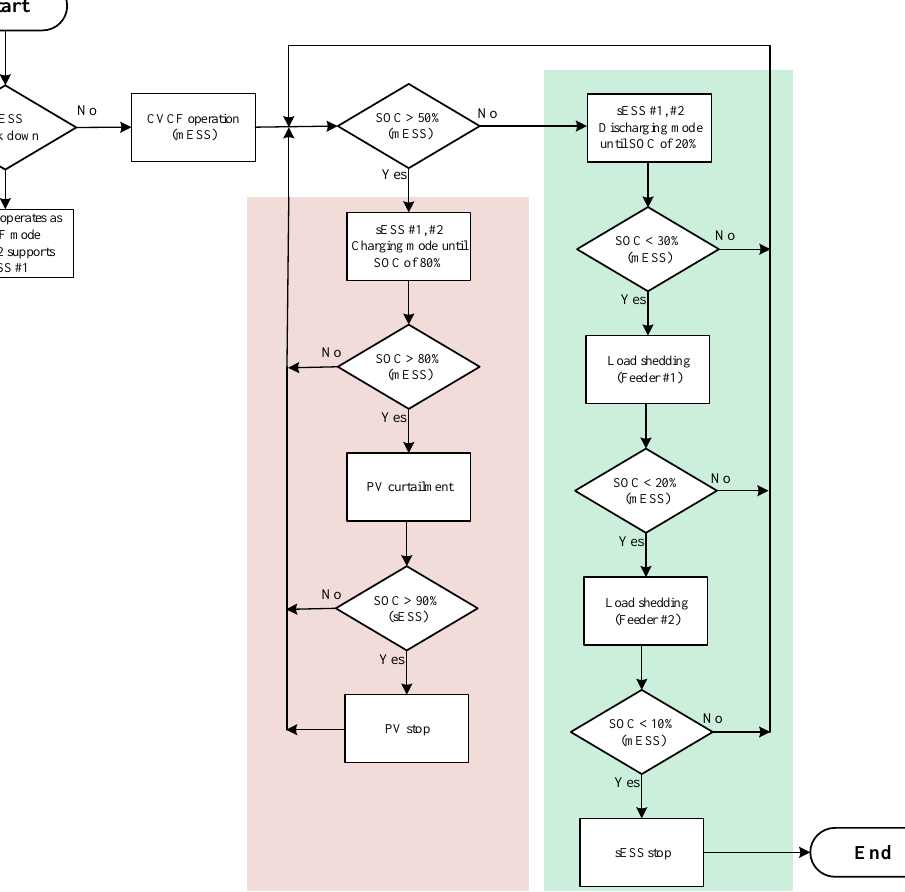
Figure 11. Energy management system (EMS) flow chat in Floreana island.